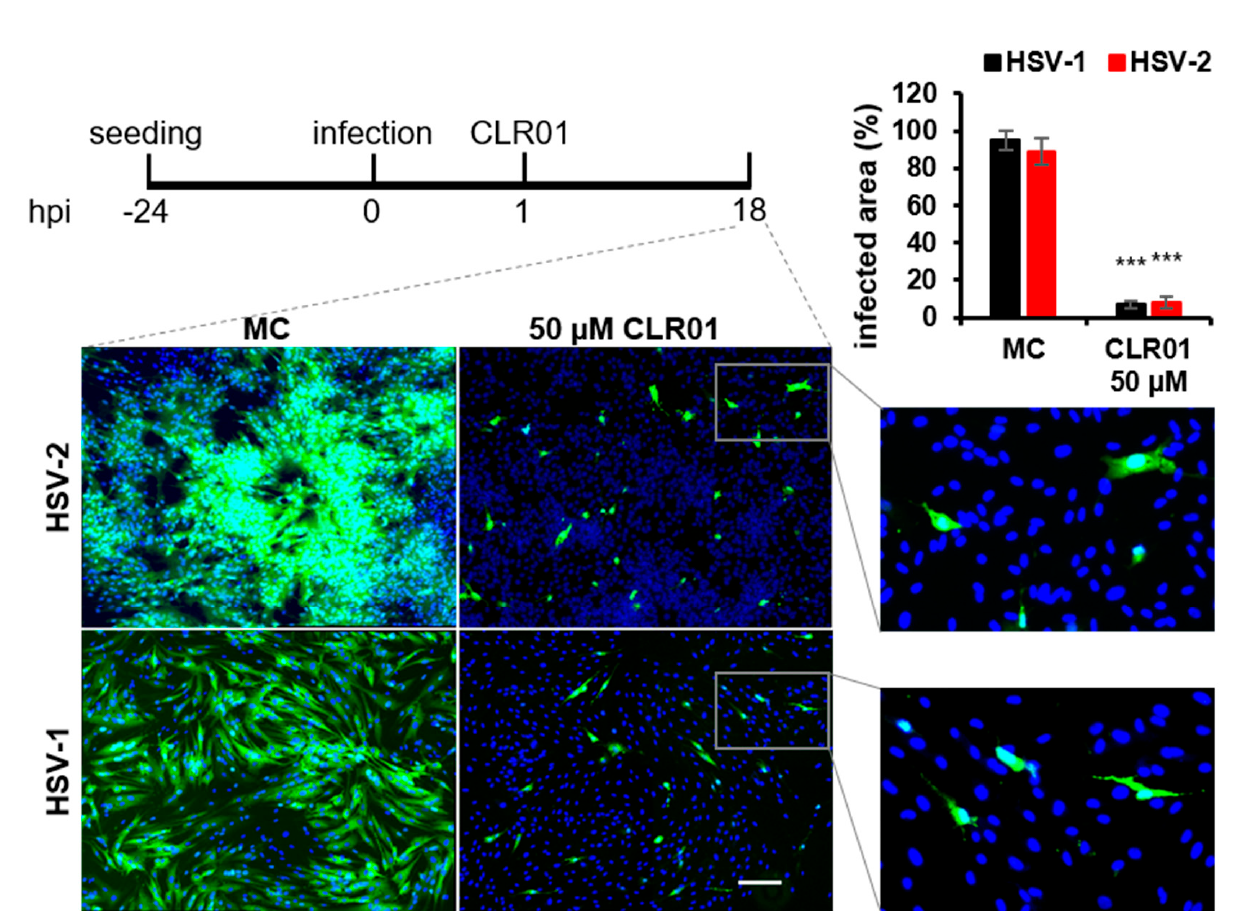
Figure 8. CLR01 inhibits cell-to-cell spread of HSV-1 and HSV-2. Human fibroblasts were infected with indicated viruses (corresponding to an infection of about 0.1–1%). Methylcellulose (MC) overlay or 50 µM CLR01 were added at 1 hpi, and the virus spread was examined at 18 hpi. Virus dissemination was determined from the GFP signal of HSV-2-infected cells and from indirect immunofluorescence staining of ICP0 of HSV-1-infected cells. Blue, DAPI-positive cells; green, HSV-positive cells. Scale bar is 200 µm. Means ± SDs of infected area (%) quantified from at least three randomly taken images for each condition. ***, p < 0.0001.